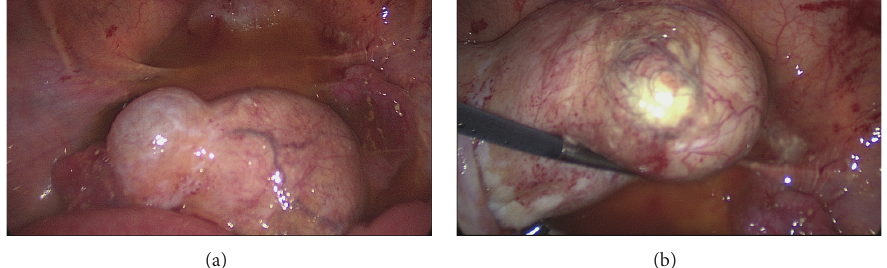
Figure 3: Laparoscopic view shows dense adhesions and the thick white to yellowish plaque-like lesion on the visceral peritoneum (a) and a huge ovarian mass consistent with a ruptured mature cystic